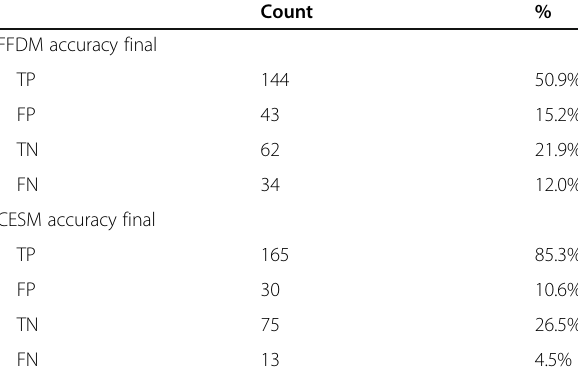
Table 4 Accuracy measures of FFDM and